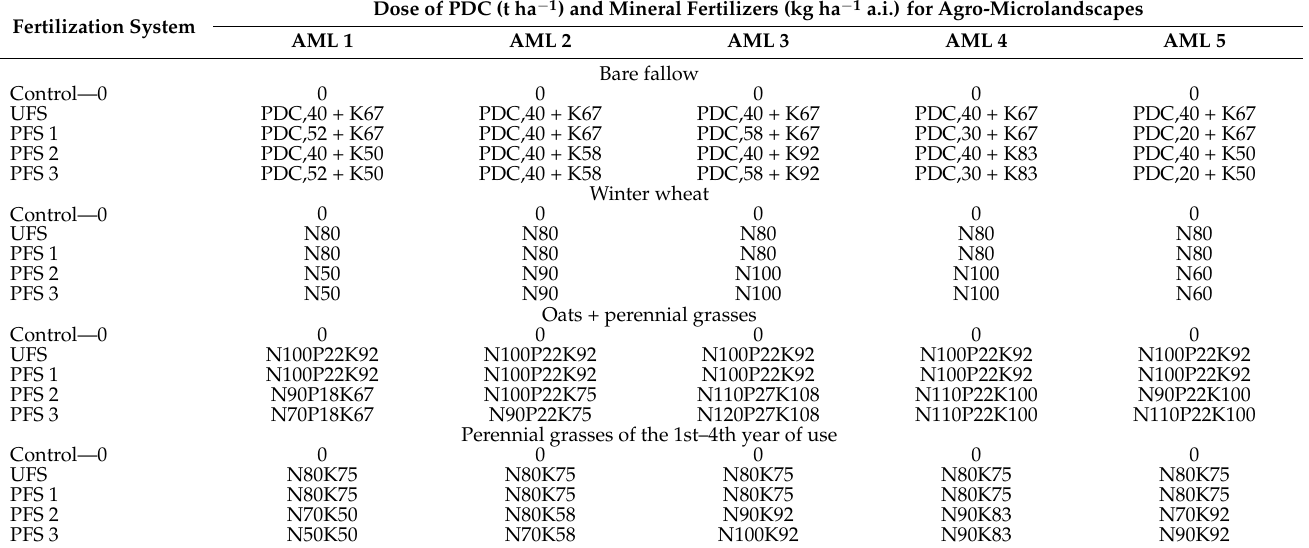
Table 2. Fertilizer doses for crops and variants of the landscape experiment. Fertilization